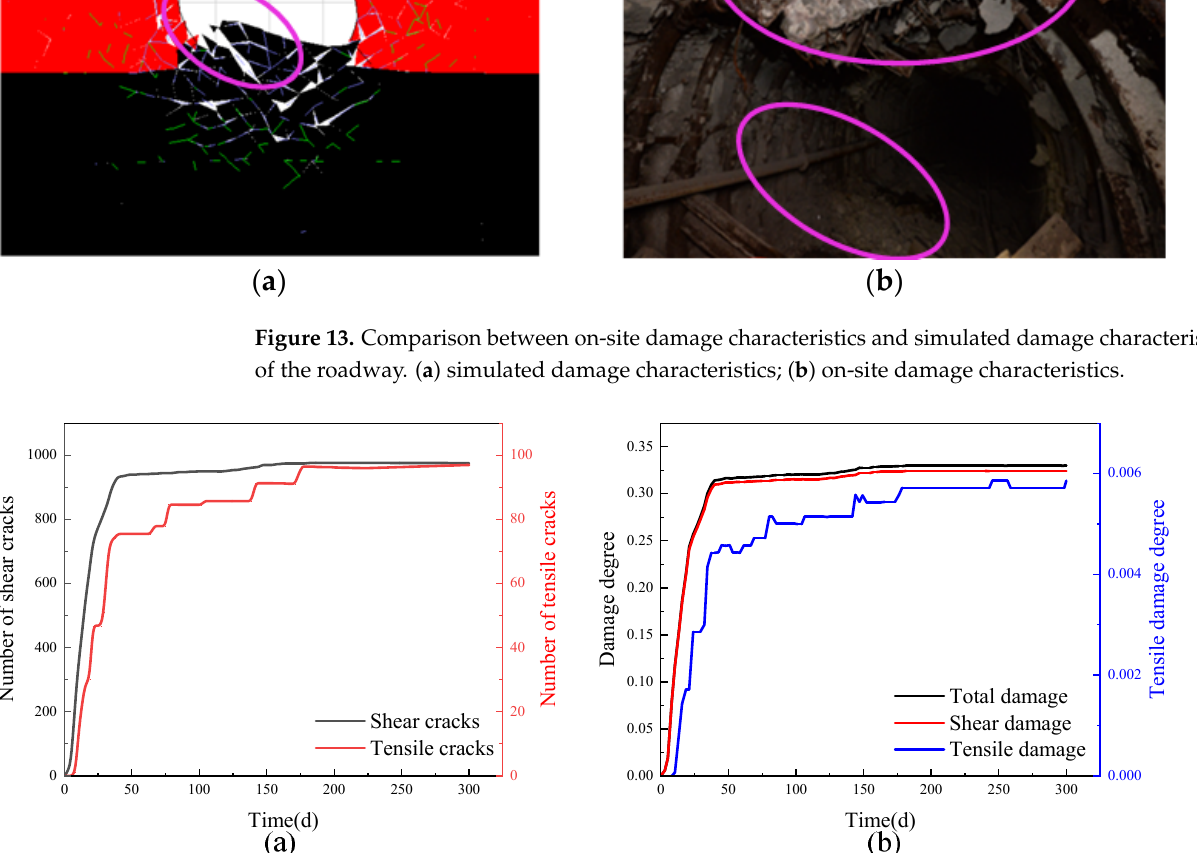
Figure 14. Evolutions of number of cracks and damage degree with time in the surrounding rock. ( a ) number of cracks; ( b ) damage degree.